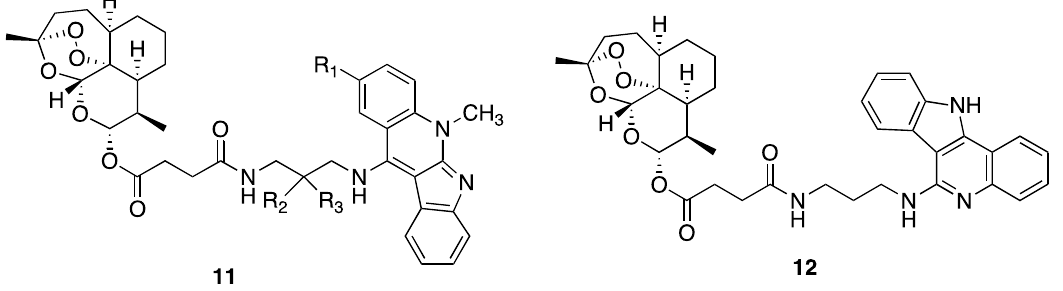
Figure 4. Structures of artemisinin-neocryptolepine hybrids.